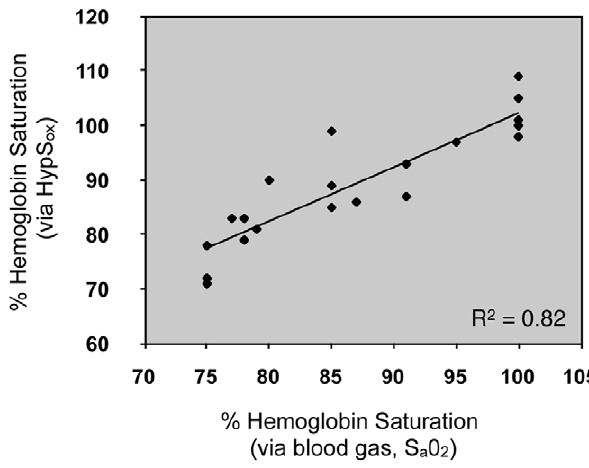
Figure 3. Correlation of arterial blood gas (S a 0 2 ) and HypS ox measurements in the rabbit. Correlation of S a 0 2 from the auricular artery and HypS ox from the retinal artery (n=4 rabbits; multiple measurements were made in all rabbits). The solid line represents the best fit linear regression. R 2 represents the square of the Pearson correlation